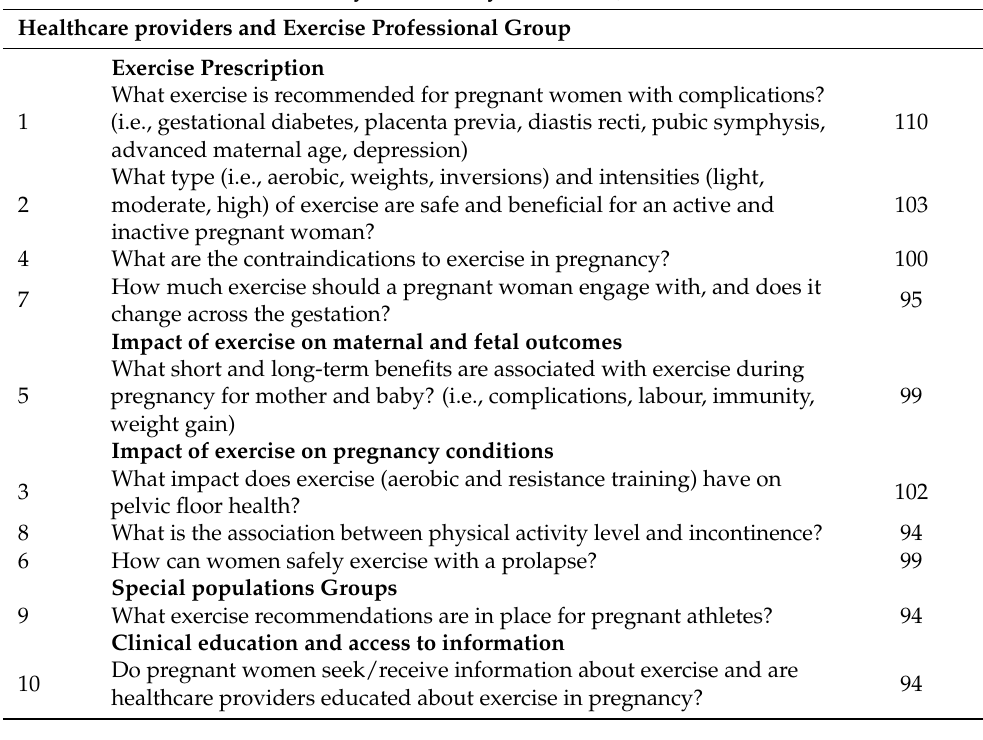
Table 2. Top 10 sedentary behavior research priorities by theme according to pregnant/postpartum women, healthcare providers and exercise professionals (for full overall league table, see Supplemen- tal Digital Content